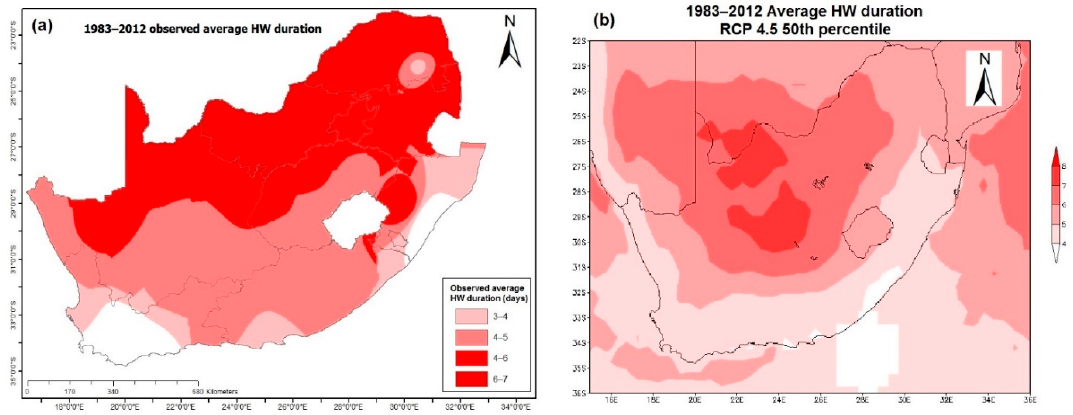
Figure 5. ( a ) Observed and ( b ) simulated HW average duration (days) across South Africa from 1983 to 2012.